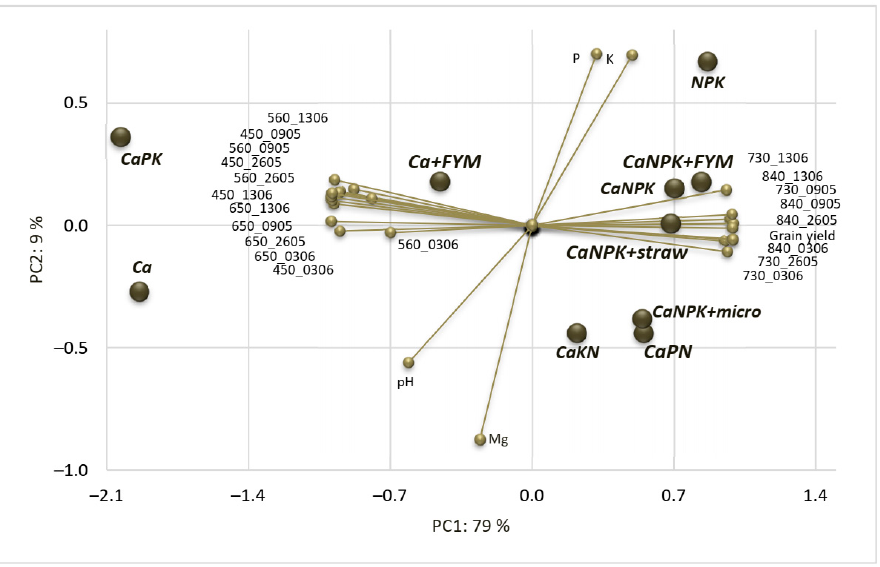
Figure 5. Results of principal component analysis presenting multivariate differences between the treatments of winter rye in experiment 2 (monoculture). treatments of winter rye in experiment 2